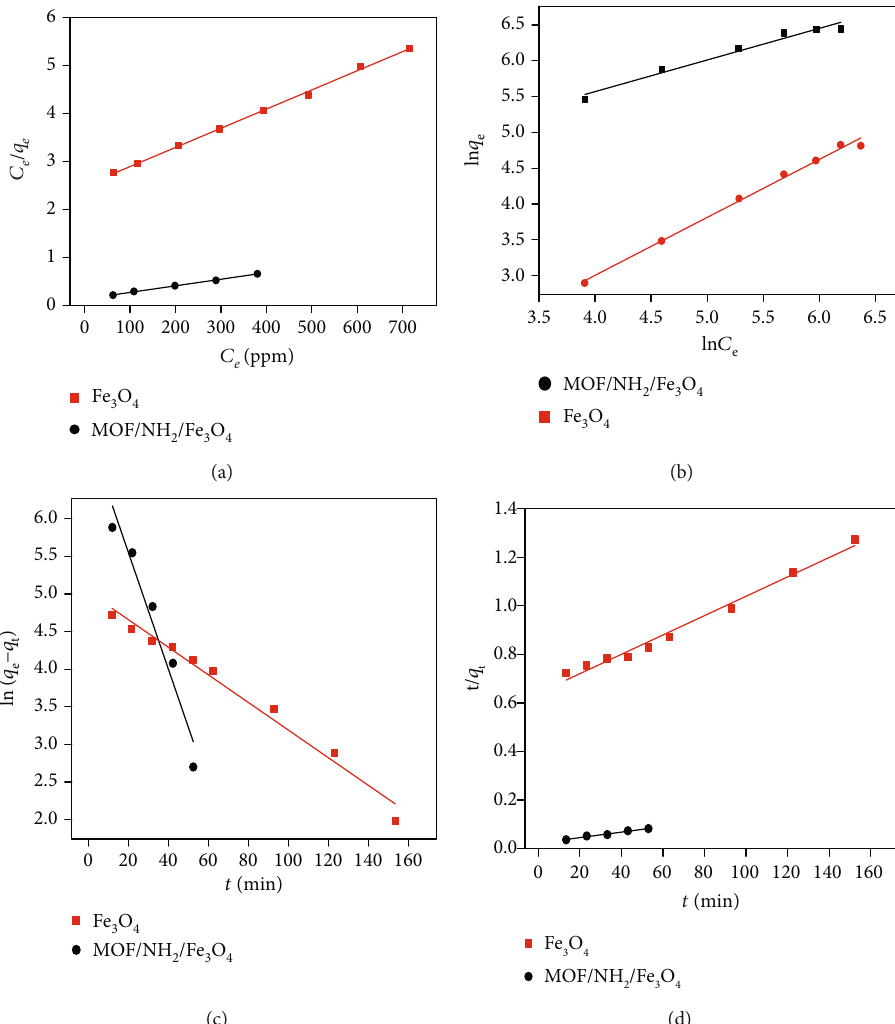
/Fe O composite and Fe O nanoparticles. 2 3 4 3 4